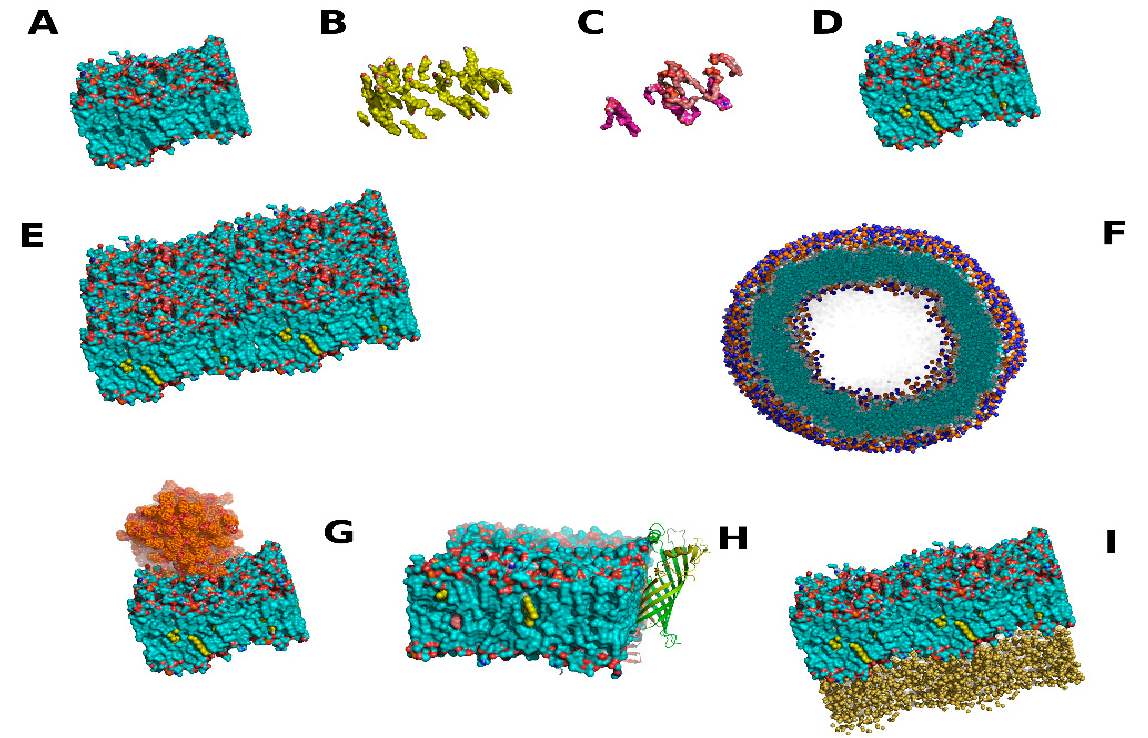
Figure 3. Creating initial structural models. ( A ) A starting piece of lipid monolayer is constructed by hand, or obtained. These usually have 1–2 lipid types such as DOPC or PS. ( B – D ), ( B ) cholesterol, yellow ( C ) Ceramides, purple, and Inositol Phosphates, Pink, are added to ( A ) using software to randomly embed these, or by hand with graphics software. This process is repeated until all membrane constituents are added, resulting in a small subunit ( D ) Final starting subunit containing several lipid or hydrophobic molecules. ( E ) The most common membrane simulation starting models are repeating duplications of ( D ), which can be generated with Pymol or other software to write out symmetry generated models, and combined. ( F ) More complex is a 5000 lipid vesicle used in studies, generated by software specialized for membrane vesicle generation, or ( G ) a hand created 60 lipid monolayer, orange, which has been extensively equilibrated before simulations. Other examples of the last stages after ( D ) are researcher specific. The most common ( H ) is a protein embedded or attached to the surface of a membrane. Software for this is presented in most MD suits, and these can be generated with graphics software. ( I ) A more specialized model for simulations, the bilayer, is attached to a solid surface, such as gold. This model again can be generated by graphics software, using software presented in suits such as LAMMPS, or with lab specific software sometimes shared